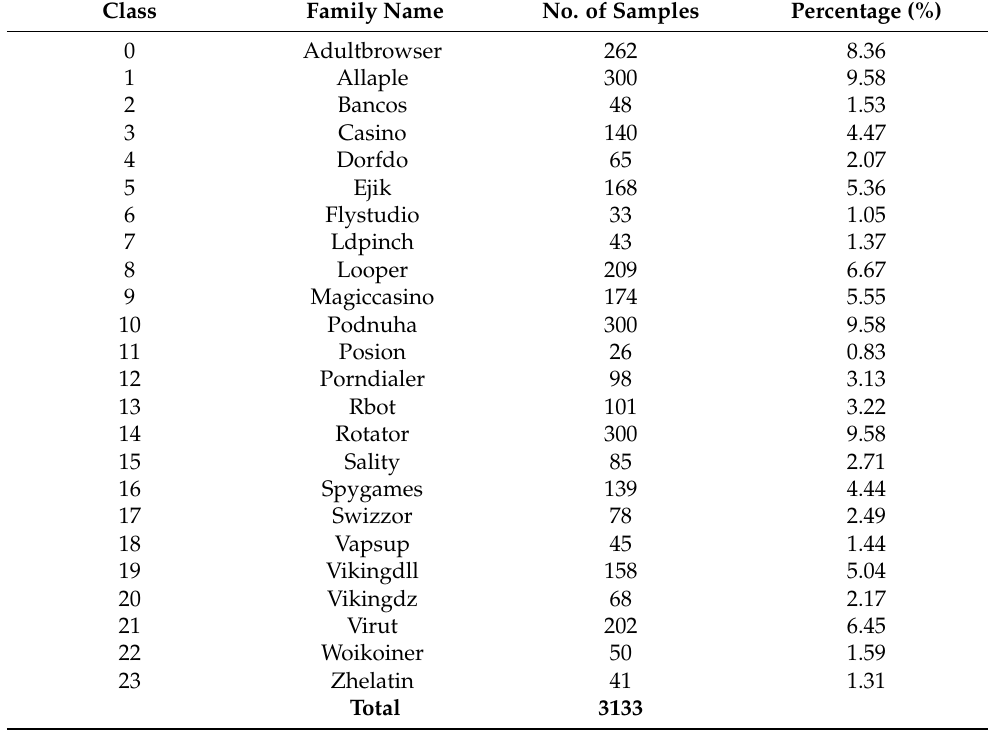
Table 3. Malheur Dataset.